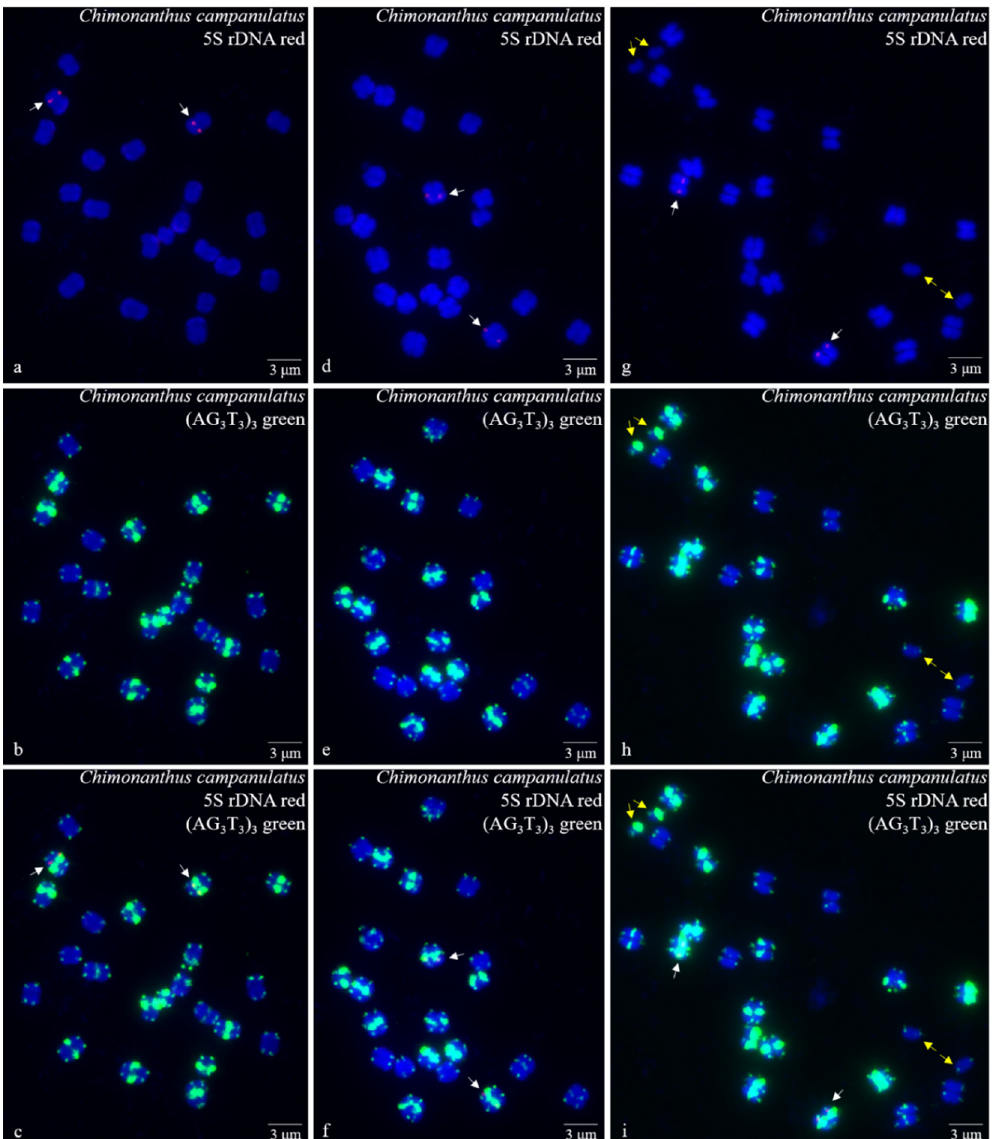
Figure 4. Mitotic metaphase (final stage in Figure 4 a – f , end of metaphase to beginning of anaphase in Figure 4 g – i ) chromosomes of Chimonanthus campanulatus after FISH. Three spreads are presented in Figure 4 a – c , Figure 4 d – f , and Figure 4 g – i . The probe oligo – 5S rDNA result with chromosomes visualized by TAMRA (red, white arrows) is shown in Figure 4 a , c , d , f , g , i , whereas the probe oligo – (AG 3 T 3 ) 3 result with chromosomes visualized by FAM (green) is shown in Figure 4 b , c , e , f , h , i . Two chromosomes have split into four chromosomes in Figure 4 g – i (yellow arrows), and 20 chromosomes are preparing to split, which shows that this spread was at the end of metaphase to beginning of anaphase. Chromosomes were counterstained by DAPI (blue) in all images. Scale bar = 3 μ M.